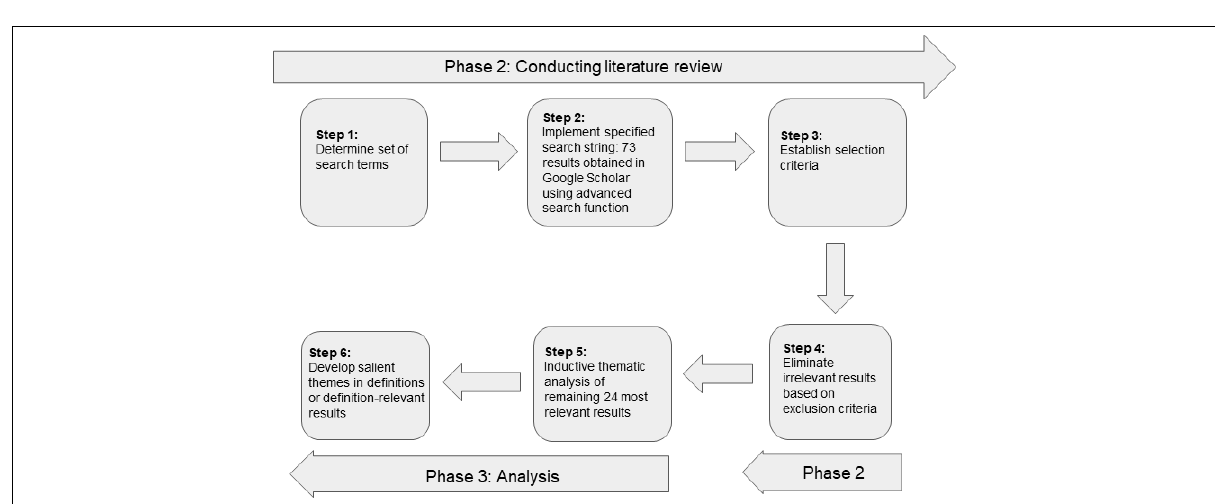
Figure 2: Detail of Phases 2 and 3: Process and figure partly modelled on Snyder 29 , Lutz et al. 30 and Brown et al.